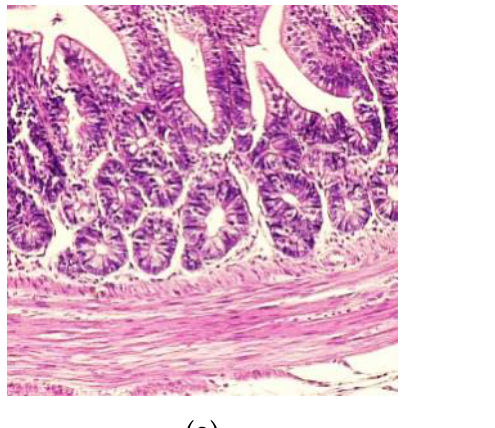
Figure 1. ( a ) Duodenal villi and crypts in normal seven-day-old chicken mucosa, Hematoxylin–eosin 200×; ( b ) Villi and cryptae duodenales in toxicated seven-day-old chicken mucous layer. Note the narrow duodenal villi and enlarged intervillar spaces (asterisks). Hematoxylin–eosin, 100×.